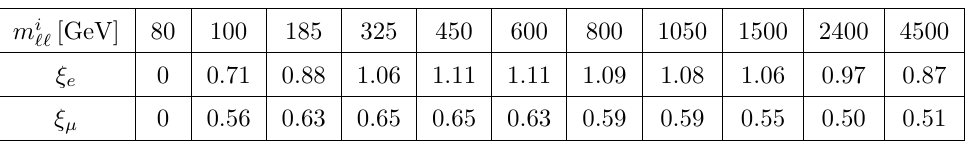
Table 1 . Interpolation nodes and values of (cid:24) ‘ . For higher values of m ‘‘ , we do not extrapolate but take the maximum value given in the table as e(cid:14)ciency rescaling